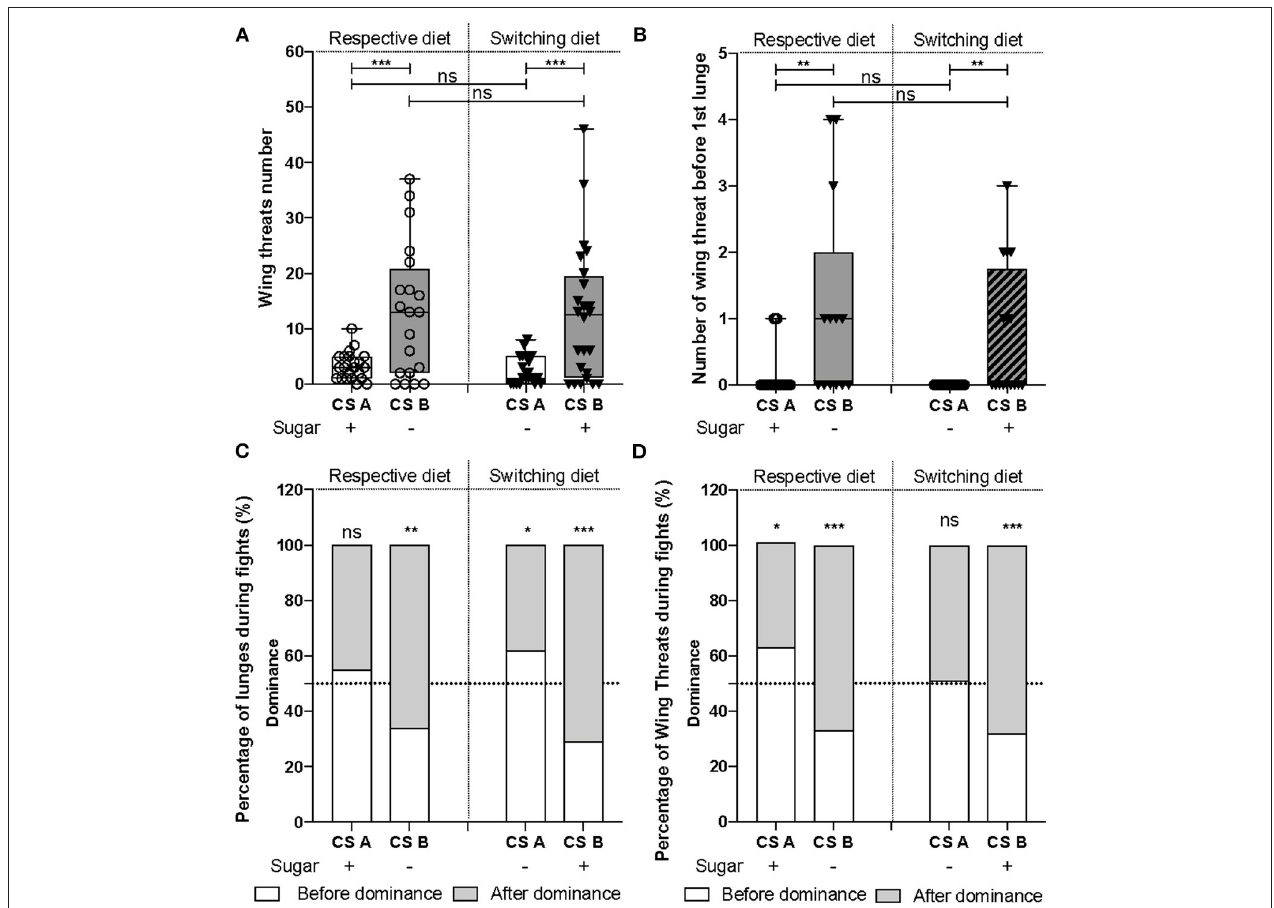
FIGURE 2 | The two CS lines employed different fighting strategies. (A) The number of wing threats [ F (1, 85 ) = 41.98, p = 6e-09] and (B) the number of wing threats before the first lunge [ F (1, 66) = 30.32, p = 6.9e-07] were significantly higher in CS B line than CS A . However, diet does not influence (A) the display of wing threats [ F (1, 84) = 0.004, p = 0.94], nor (B) the number of wing threats before the first lunge [ F (1, 65) = 0.34, p = 0.56]. (C) CS A lunged equally often before and after dominance was established ( χ ² test CSAsugar + = 1, d.f = 1, p = 0.32; χ ² test CSAsugar − = 5.7, d.f = 1, p = 0.02), while CS B , preferentially lunged after dominance ( χ ² test CSBsugar + = 17.64, d.f = 1, p = 0.0001; χ ² test CSBsugar − = 10.24, d.f = 1, p = 0.0014). (D) In CS A , wing threats were displayed throughout the fight ( χ ² test CSAsugar + = 6.18, d.f = 1, p = 0.0129; χ ² test CSAsugar − = 0.04, d.f = 1, p = 0.84), while in CS B , they were observed mostly after dominance ( χ ² test CSBsugar + = 12.96, d.f = 1, p = 0.0003; χ ² test CSBsugar − = 11.56, d.f = 1, p = 0.0007). * P < 0.05, ** P < 0.01, *** P < 0.001, ns, not